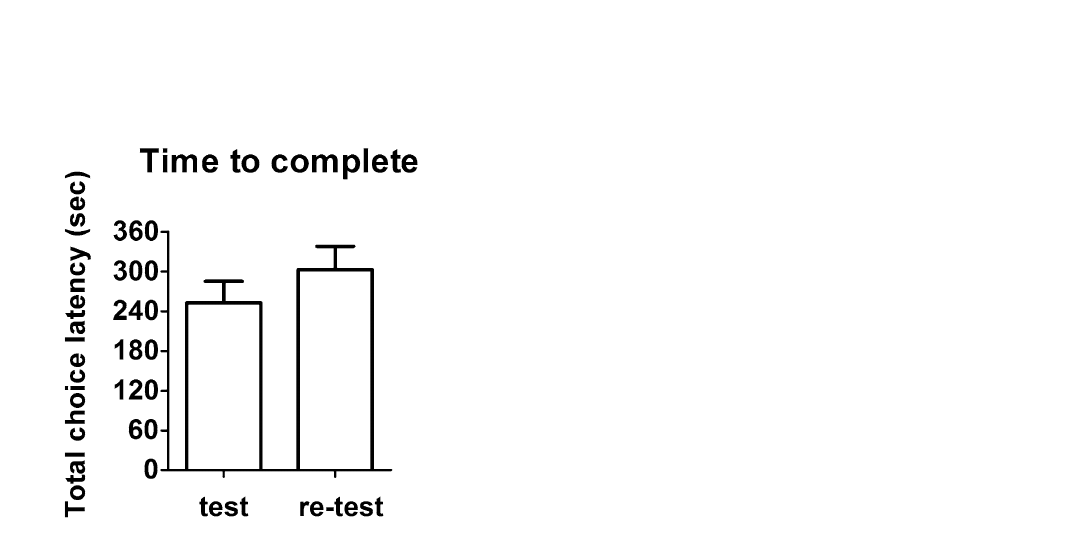
Figure 5. Total choice latency (from T0 to T6) of healthy wild-type mice in the test and re-test sessions of spontaneous alternation T-maze (inter-session effect of repetition). No significant difference was observed between total choice latencies of test and re-test sessions. Data are presented as mean + SEM (n =